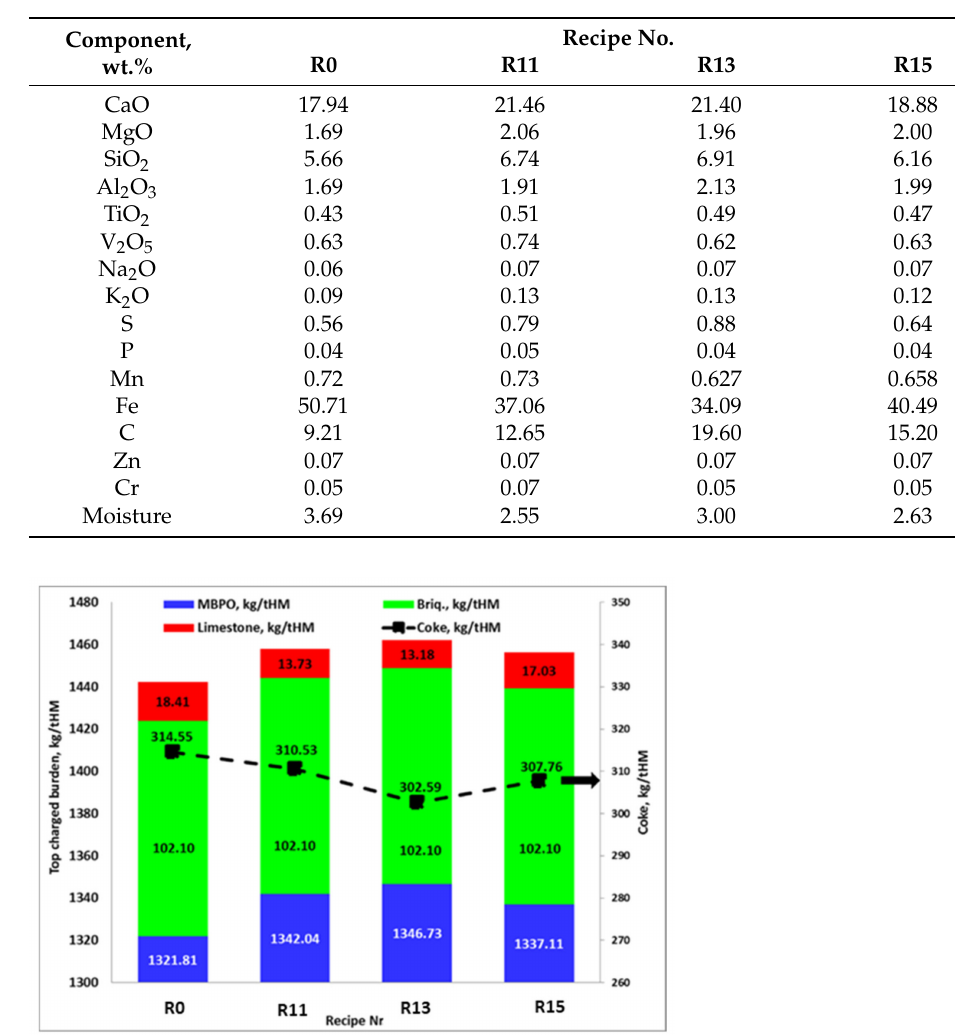
Table 8. Chemical composition of reference and developed briquettes.